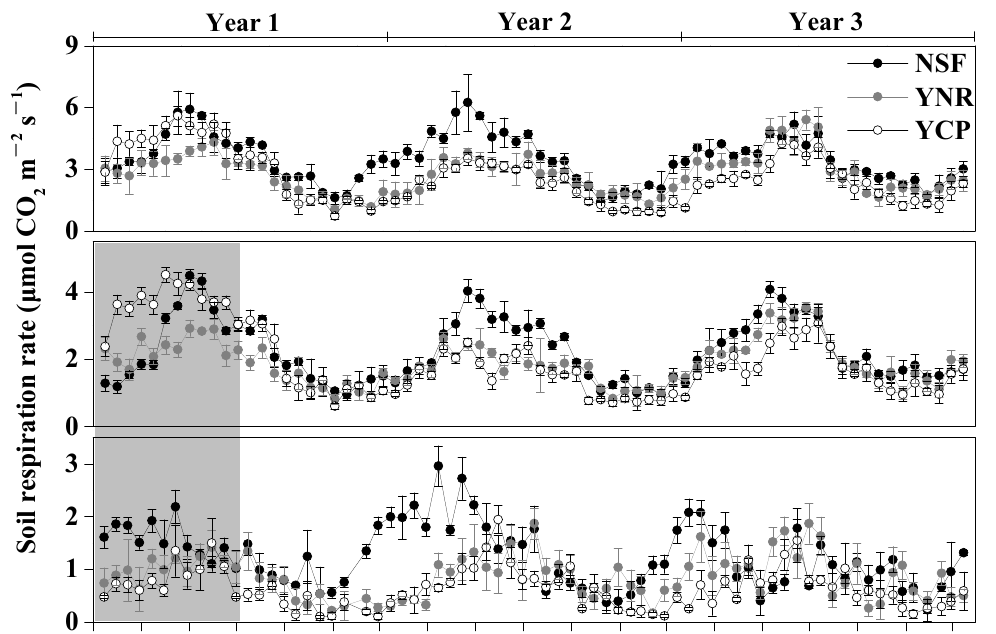
Figure 2. Temporal variation of mean (±standard deviation) soil respiration (Rs), heterotrophic respiration (Rh), and autotrophic respiration (Ra) rates in the first three years following a reforestation experiment from 15 April 2012 to 15 April 2015 in a mature natural secondary forest (NSF), a young forest established through assisted natural regeneration (YNR), and a young Castanopsis carlesii plantation (YCP). Heterotrophic respiration rates measured in the first six month were shaded in gray and not used in the comparisons among the forests to account for transient effects caused by the decomposition of dead roots.